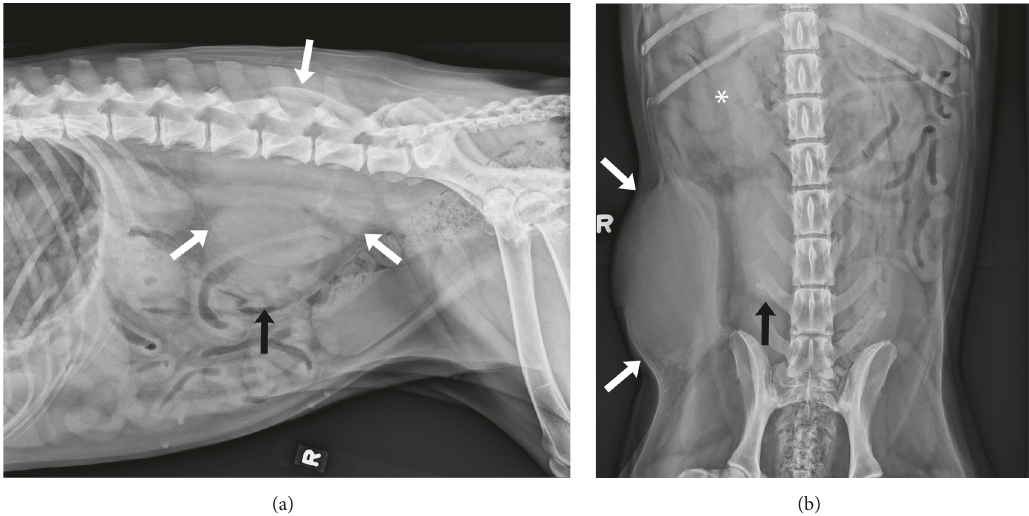
Figure 1: (a) Right lateral and (b) ventrodorsal radiographs of the caudal portion of the abdomen. A large, well-defined, ovoid, soft tissue opaque mass is seen in the right caudal abdominal subcutaneous tissues (white arrows). A large, relatively well-defined, soft tissue opaque mass is noted in the right caudal abdominal cavity (black arrow), caudal to the right kidney ( ∗ ).